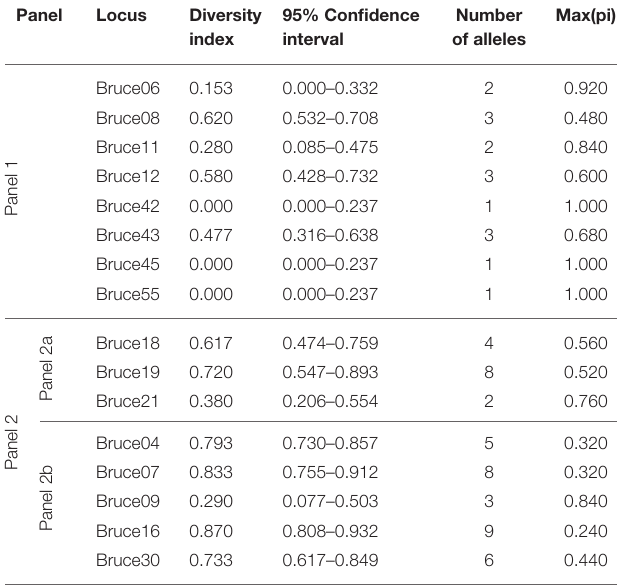
TABLE 2 | The Hunter Gaston Diversity Index for different loci of West African field strains of B. abortus biovar 3 (i.e., from Ivory Coast, Niger, Nigeria, The Gambia, and Togo) based on MLVA 16